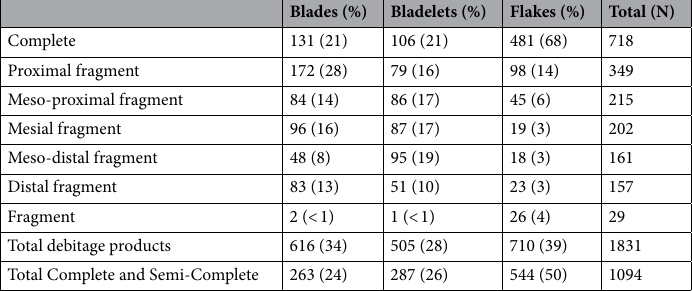
Table 1. Classification of the piece-provenienced debitage from Române ș ti- Dumbrăvi ț a I, GH3.